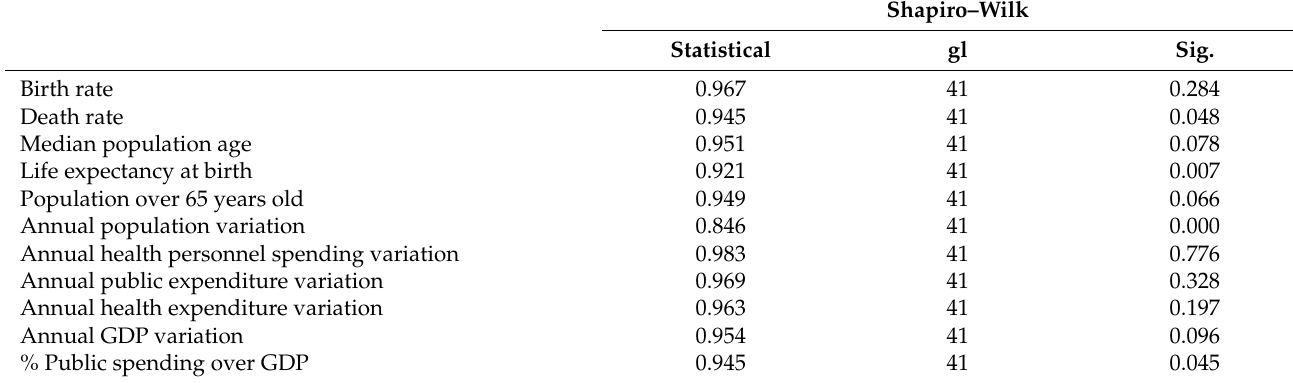
Table 2. Normality